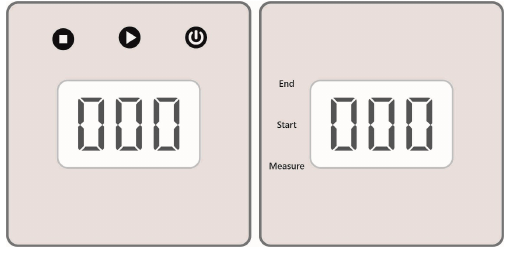
Figure 1. Image button ( left ) and text button ( right ).